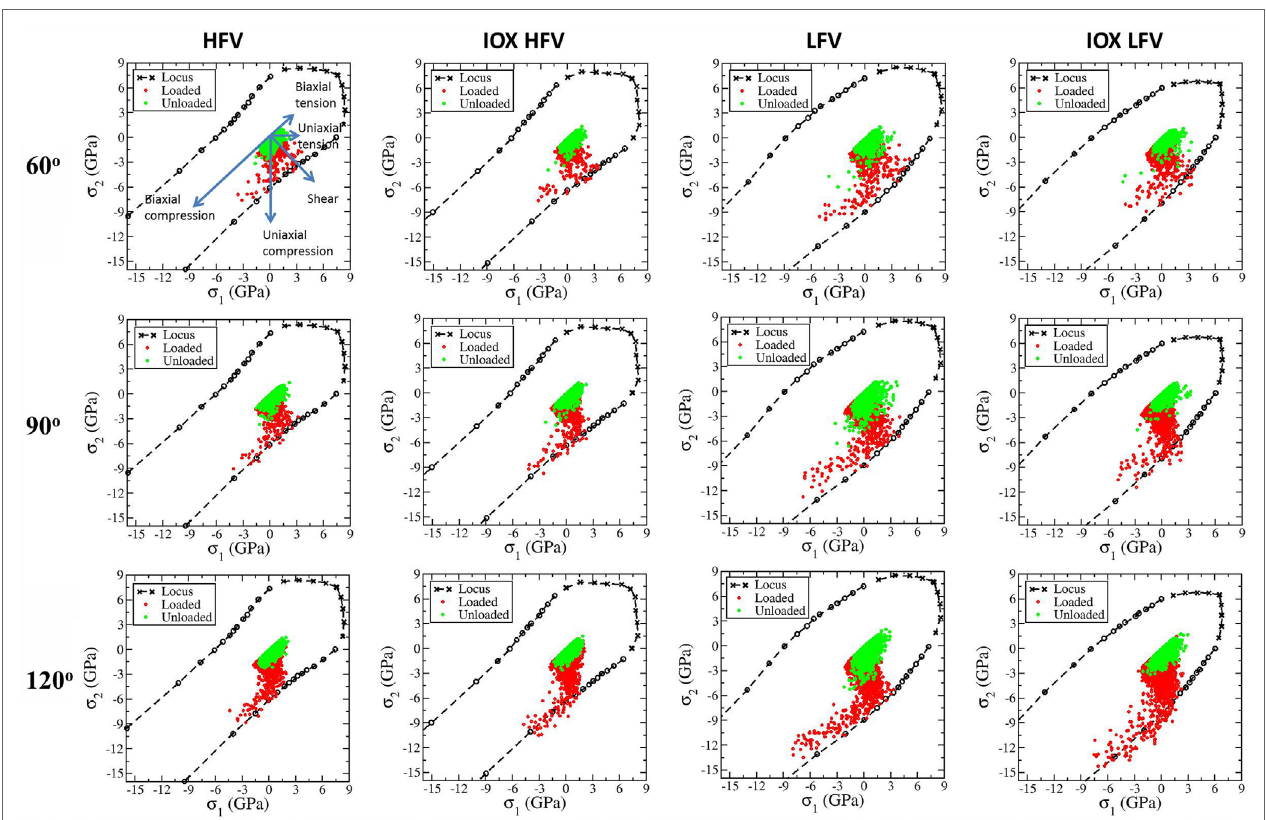
FigUre 7 | scatter plot of all the local stress states under indentation during loading and after unloading with labeled indenter angle in the in-plane principal stress domain along with the corresponding fracture/yield locus . The meaning of the directions in the principal stress domain is illustrated in the first plot. From left to right, each column corresponds to HFV, IOX HFV, LFV, IOX LFV samples. From top to bottom, each row corresponding to 60°, 90°, 120°